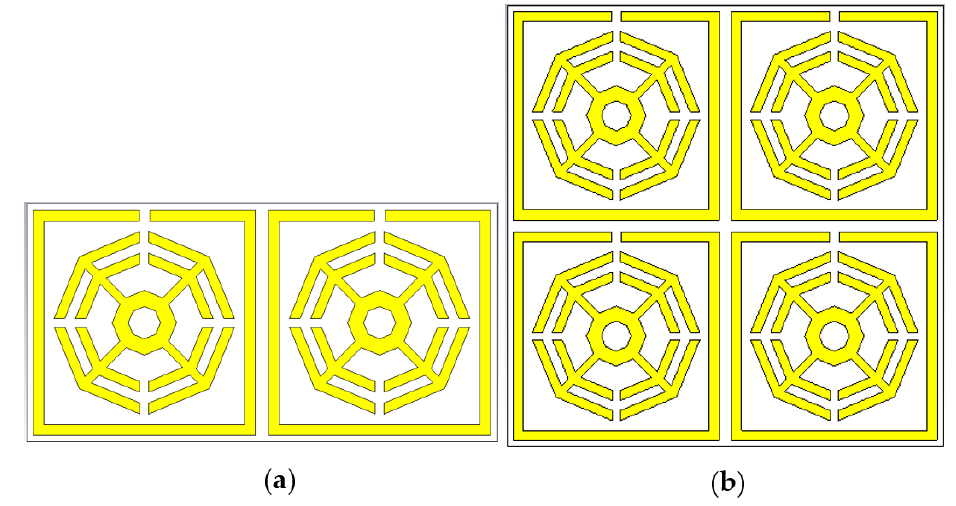
Figure 17. Array combinations: ( a ) 1 × 2 array; ( b ) 2 × 2 array.